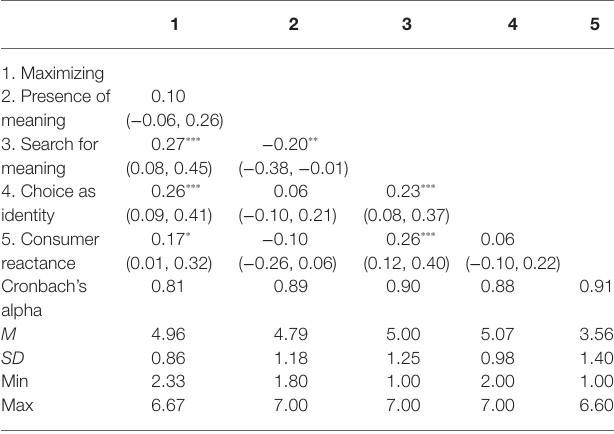
TABLE 2 | Descriptive statistics and